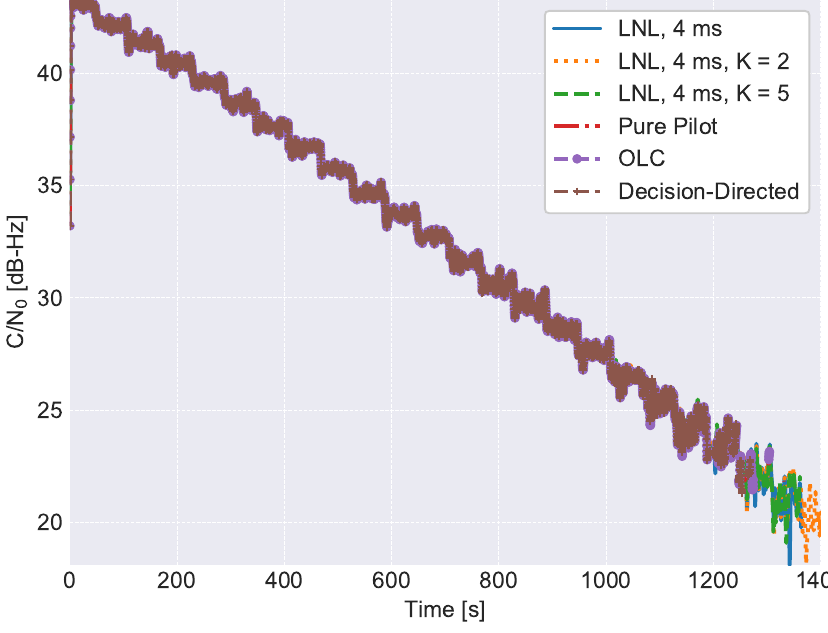
Figure 9. Comparison of the C / N 0 estimates obtained as function of time and for different processing